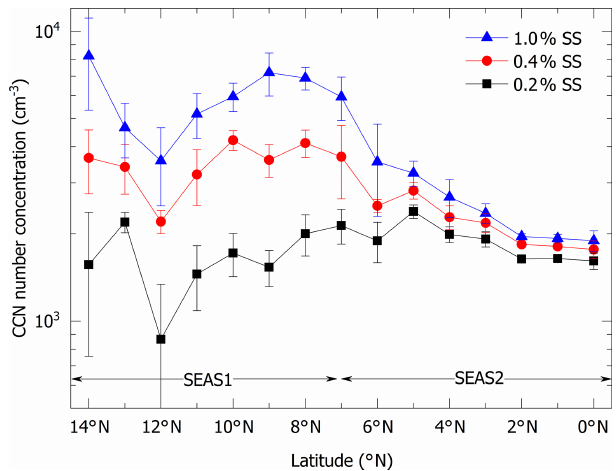
Figure 2. Latitudinal variation in the CCN number concentration at 0.2%, 0.4% and 1.0% supersaturations (SS) over the southeastern Arabian Sea (SEAS). The vertical bars on each data point indicate the standard deviation of the measurements. The SEAS region is further divided into SEAS1 and SEAS2 based on the origin of air mass back trajectories and proximity to the mainland.